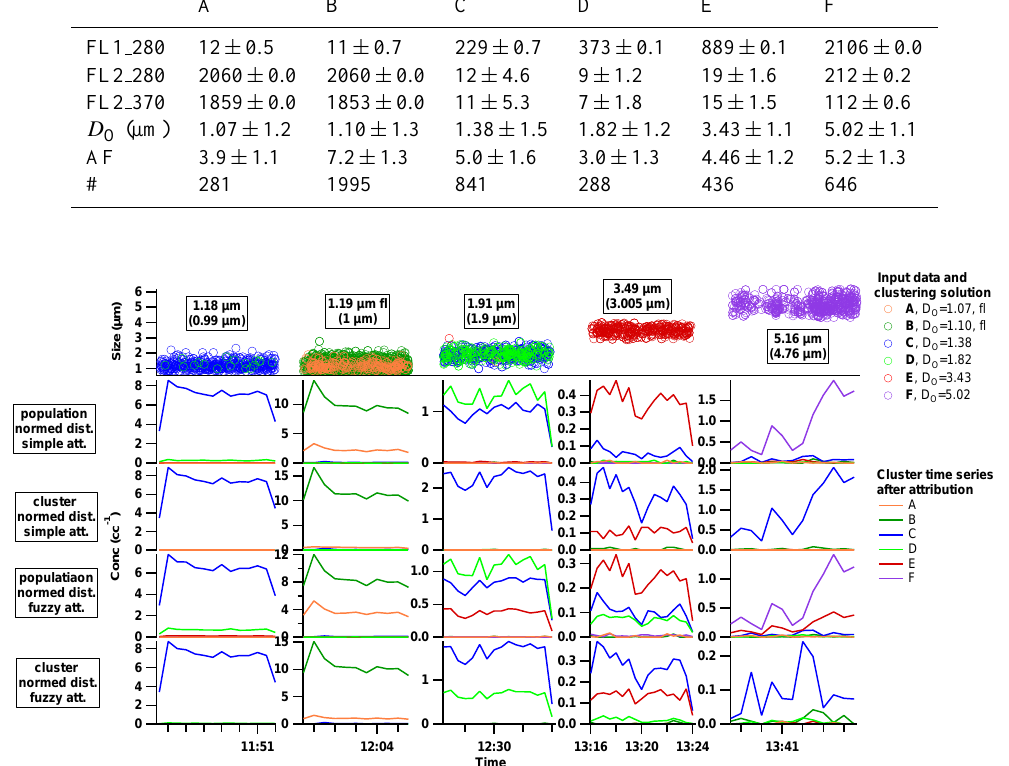
Fig. 5. Top plot shows the single-particle data input to the cluster analysis routine ( ∼ 30% of all the particles that were measured) coloured by their cluster, as defined in Table 3. Particle size and fluorescence for each retrieved cluster are detailed in the legend. Measured PSL optical diameters are detailed in boxes, with the actual PSL physical diameters in brackets. Below are cluster concentration time series after the remaining particles are attributed to the resolved clusters, using four different attribution algorithms, detailed on the left. The x-axis is discontinuous between the introduction of different PSLs. The y-axes are inconsistent between subplots.